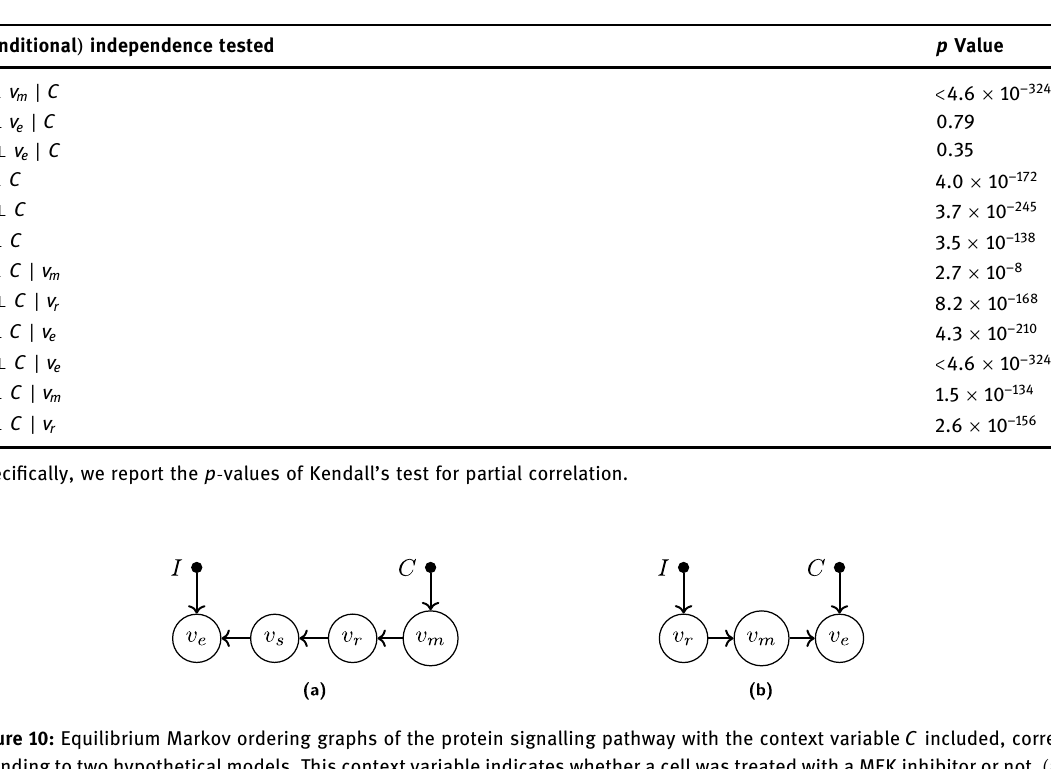
Table 3: Results of conditional independence tests on the ( log - transformed ) protein expression data of [ 18 ]